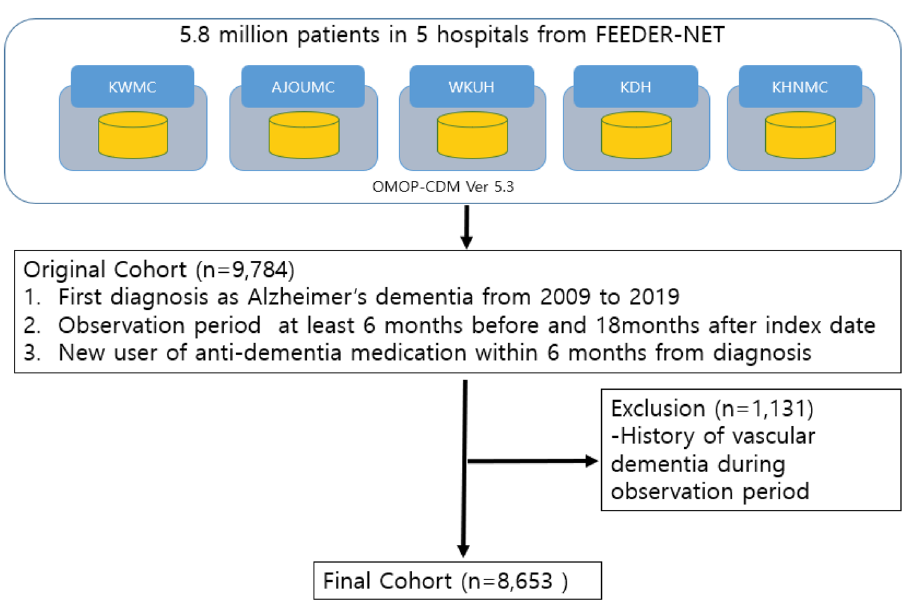
Figure 2. Study population. The data was analyzed as Observational Medical Outcomes Partnership Common Data Model (OMOP-CDM) with KWMC; Kangwon University Medcal Center, AJOUMC; Ajou University Common Data